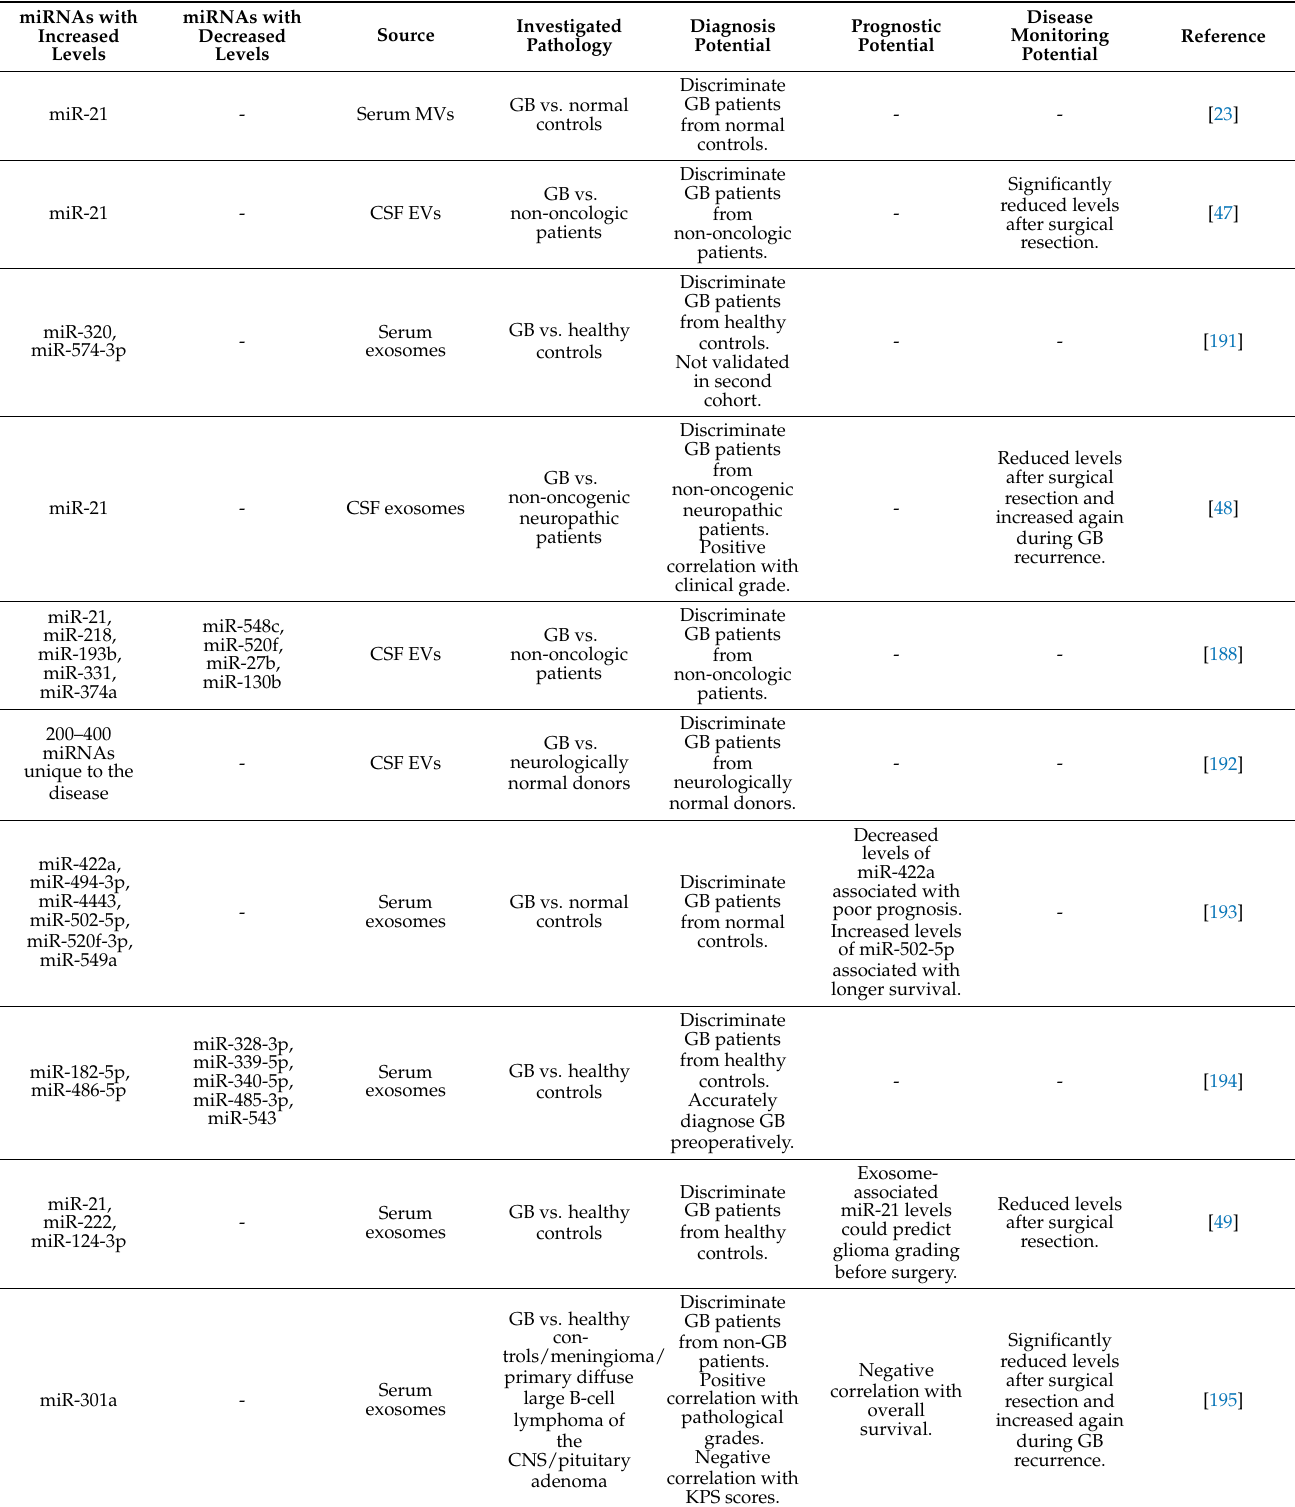
correlation with KPS